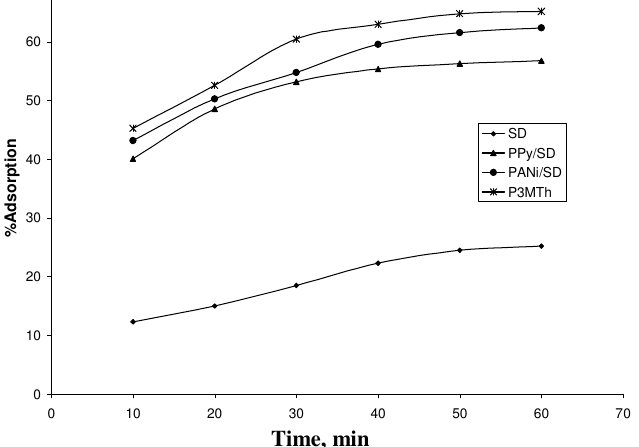
Figure 8. Effect of contact time on the adsorption of As(III). SD, PPy/SD, PANi/SD and P3MTh/SD.